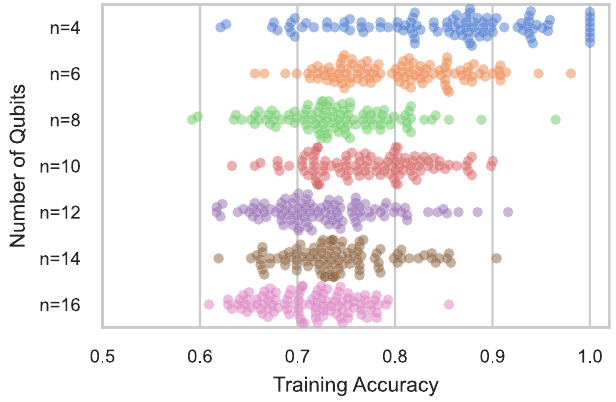
Fig. 2 | Teacher-student evaluation for the n -qubit QCNN. The student circuit is unable to learn the teacher circuit as the number of qubits grows, converging to a local minimum of the loss landscape. The existence of a global optimum is guar- anteed as the teacher circuit is drawn from a random initialization of the same QCNN structure of the student circuit. Here, for a ranging number of qubits, 100 student circuits are trained to learn randomized teacher circuits of the same form and the resulting swarm plots of the fi nal training accuracy are